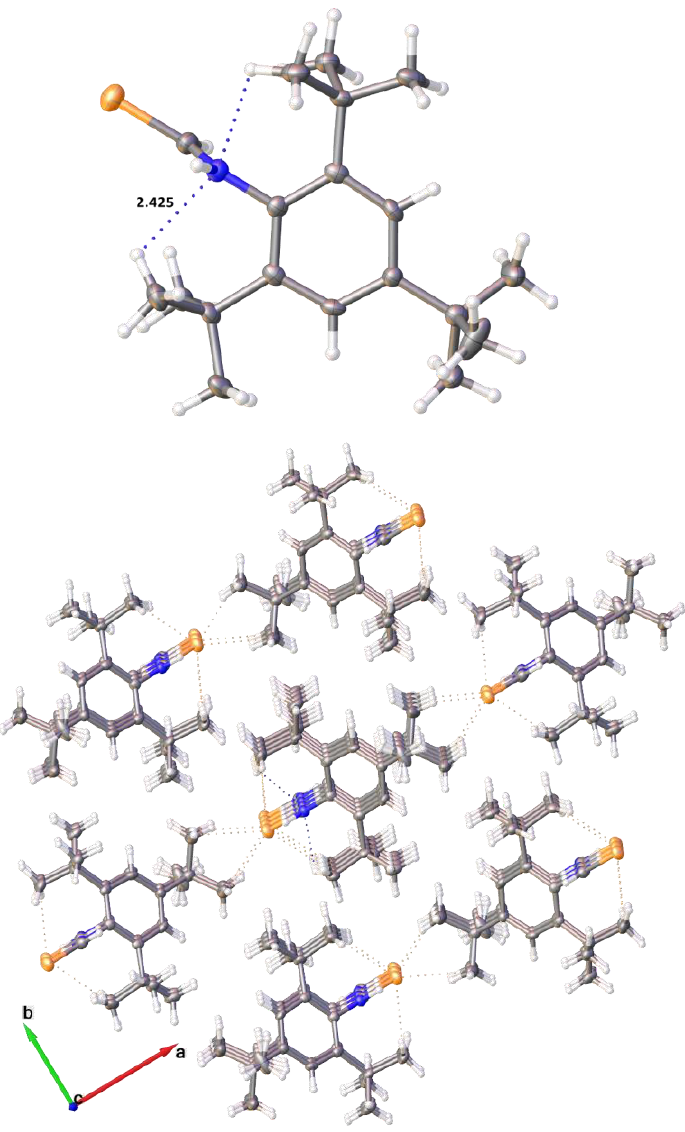
Figure 9. ( a ): intramolecular interactions seen in 5 ; ( b ): supramolecular structure in 5 . Atoms colors are the same as in Figure 8 except hydrogen, which is white.